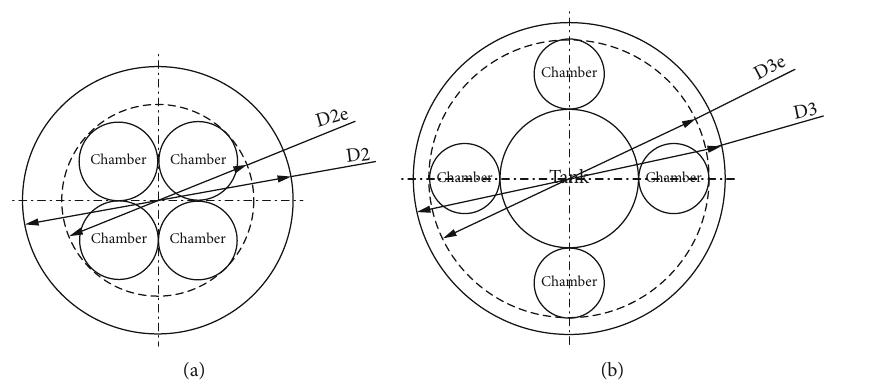
Figure 10: Envelope diameter of the 2nd HRM and 3rd HRM: (a) cross section of the 2nd stage (four-chamber); (b) cross section of the 3rd